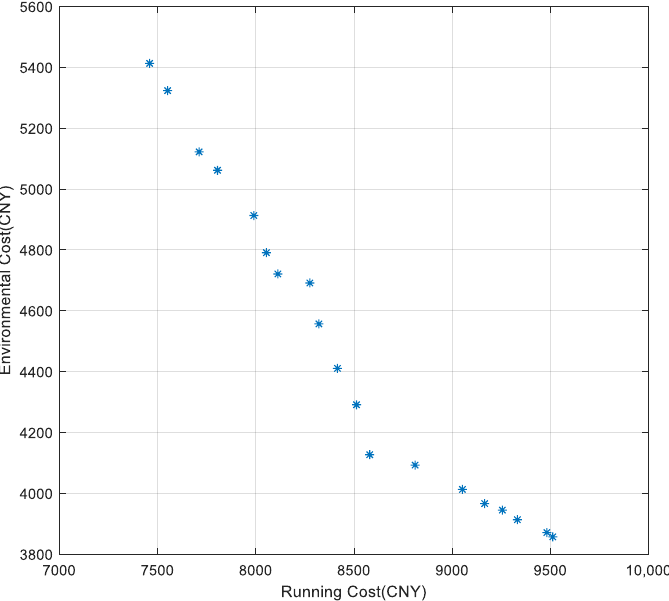
Figure 9. The Pareto solution set provided by the multi-objective RSSA for a typical day in summer.